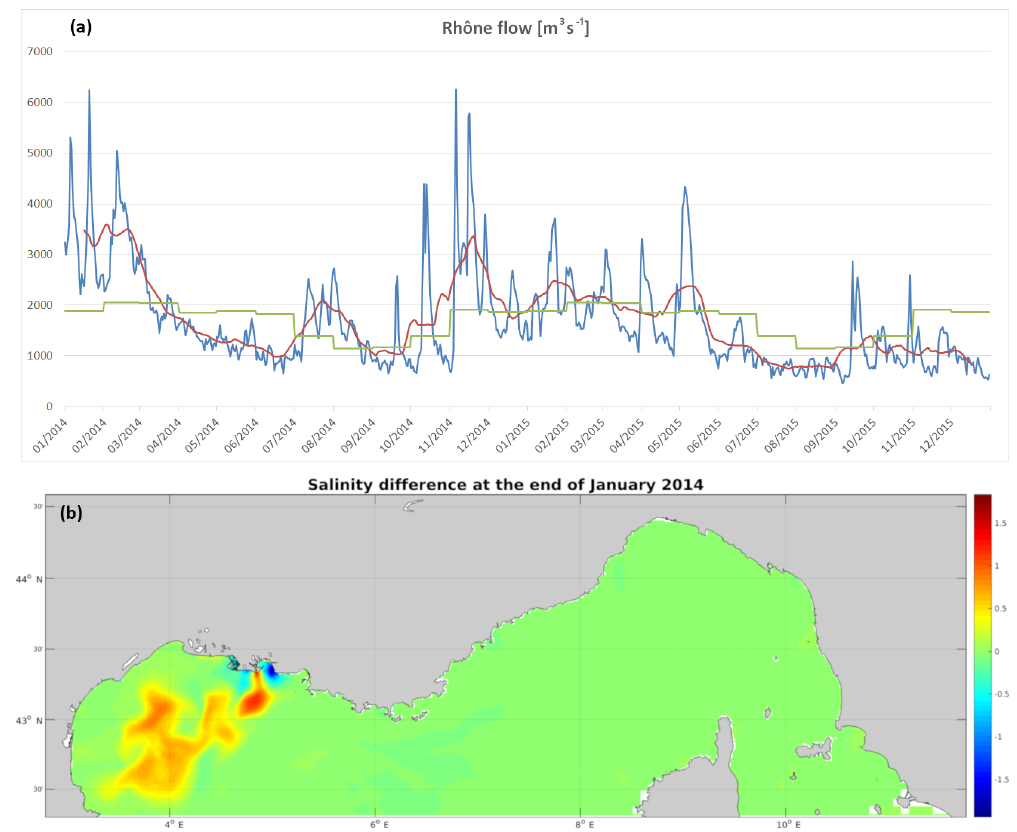
Figure 1. (a) Rhône River discharge from (green) the climatology, (blue) the measurements by the Compagnie du Rhône at the Beaucaire station and (red) the 1-month moving average of the measurements. (b) Difference of surface salinity in two different model runs of the nested grid on 28 January 2014, when using climatological or measured Rhône discharge values (i.e. using the green or blue curve in a